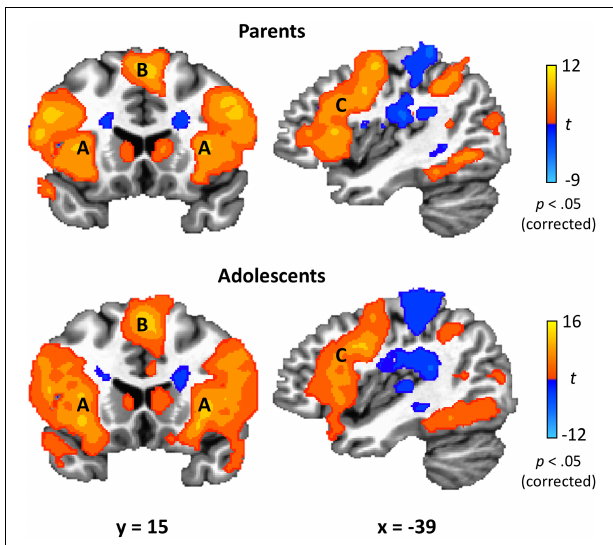
FIGURE 4 | TEAM task results. In response to their partner’s costly error, both parents and adolescents exhibited robust activation in brain regions related to affective circuitry and emotion regulation, including anterior insula (A) , medial superior frontal gyrus (B) , and dorsolateral prefrontal cortex (C) . Coordinates are in Talairach